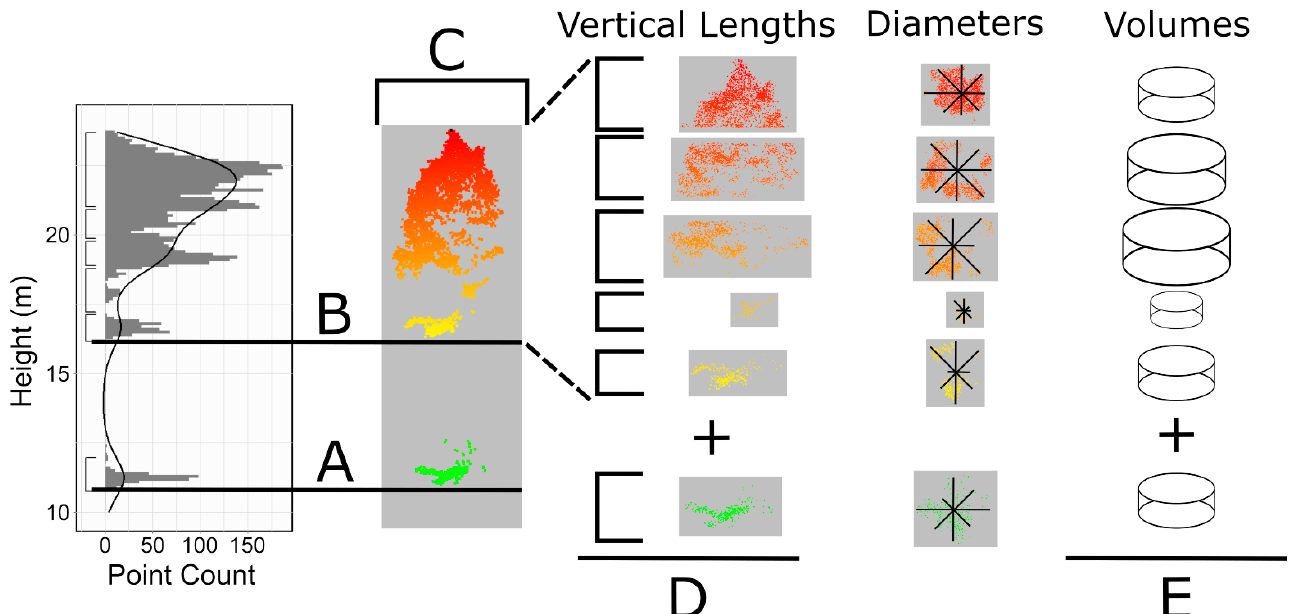
Figure 4. An overview of the live branch cluster and total tree metric extraction. ( A ) Height of the lowest live branch cluster; ( B ) live crown base height; ( C ) crown width; ( D ) total crown length; ( E ) total live branch volume.